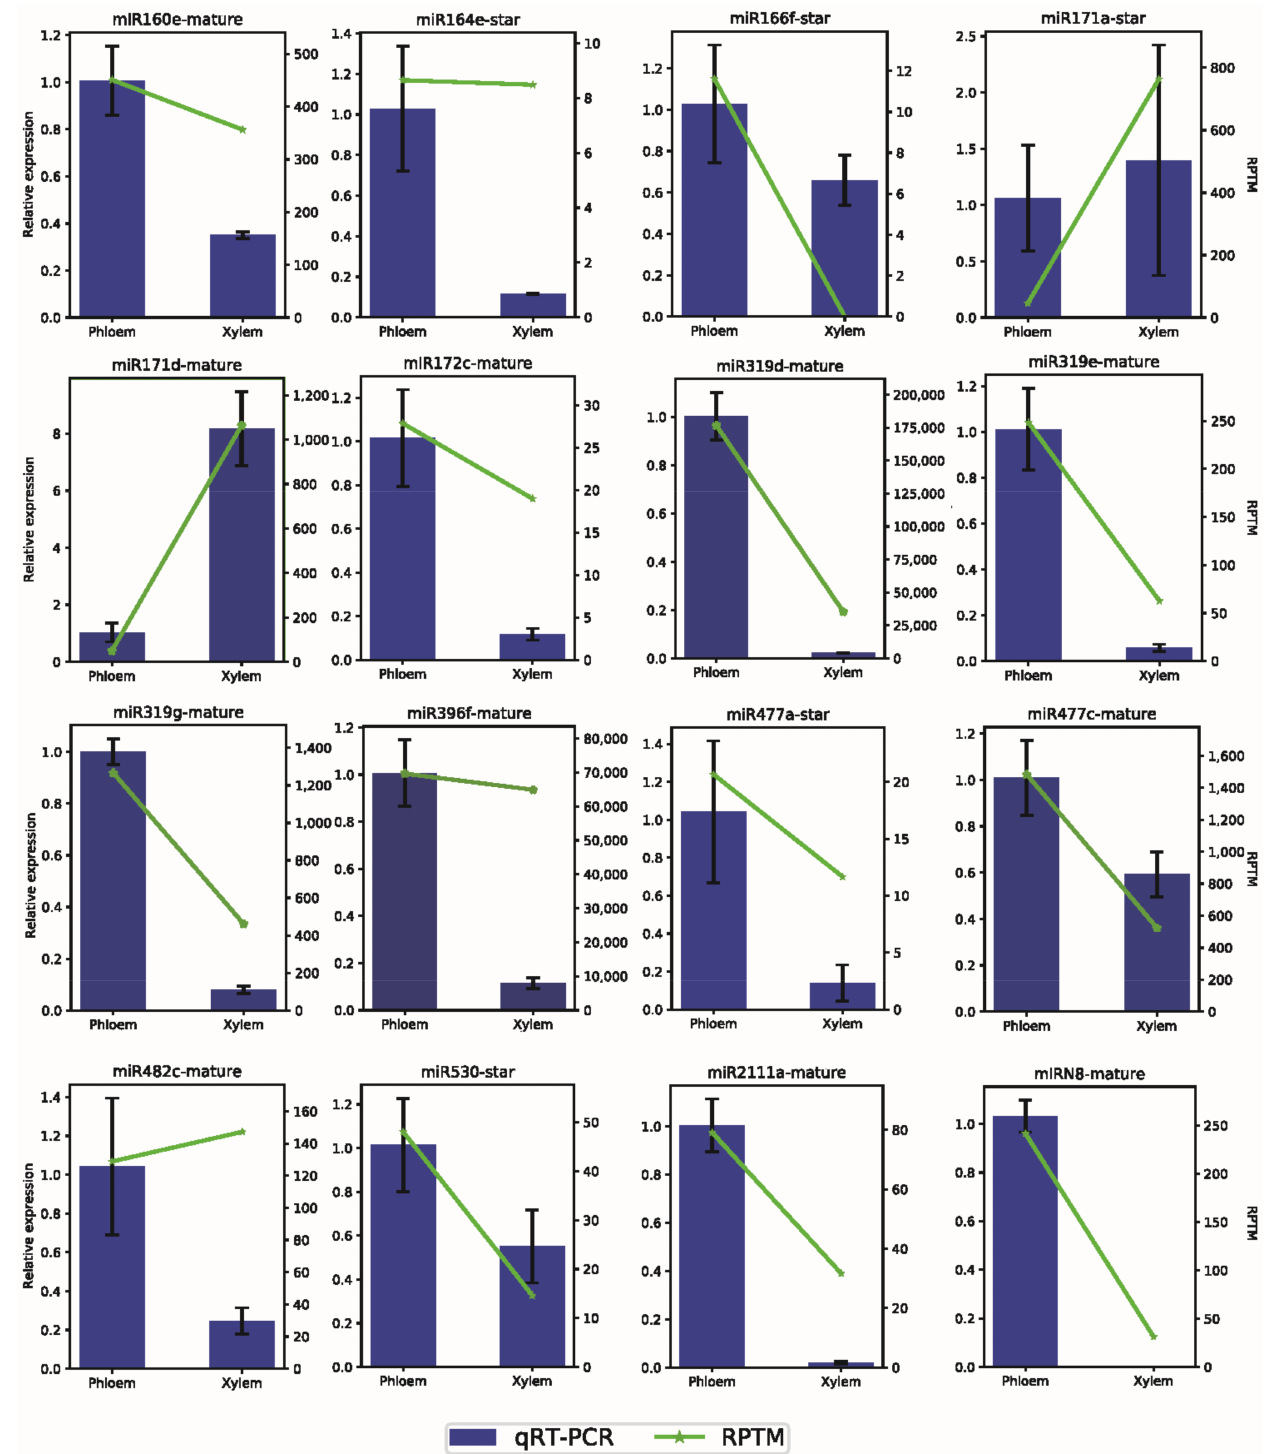
Figure 5. Tissue expression patterns of candidate miRNAs involved in lignin and cellulose biosynthe- sis validated by